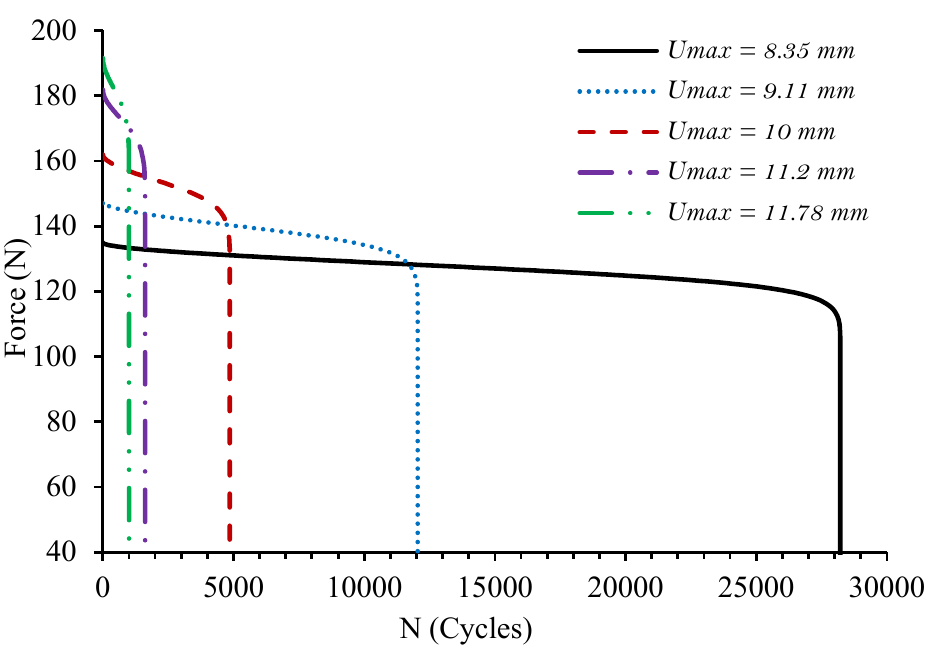
Figure 14. Simulated force-cycle history for PA66GF30 specimens. Table 6. Experiment and numerical number of cycles to failure of PA66GF20. Table 7. Experimental and numerical number of cycle to failure of PA66GF30.